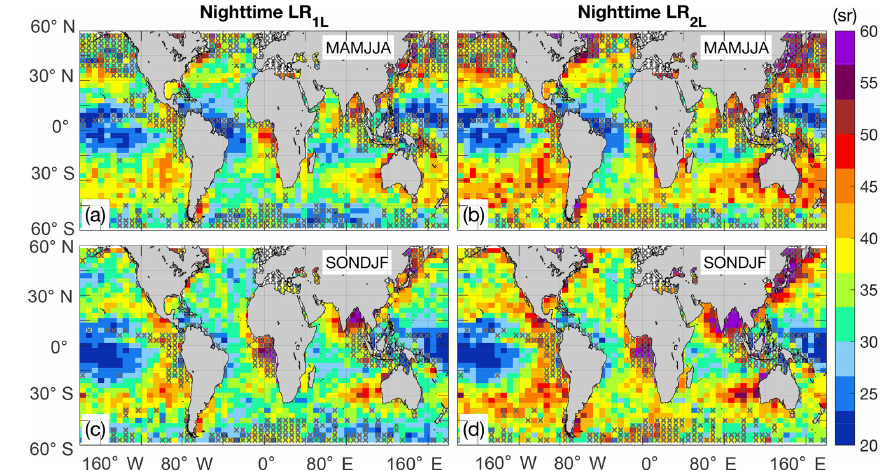
Figure 10. As in Fig. 9 but for